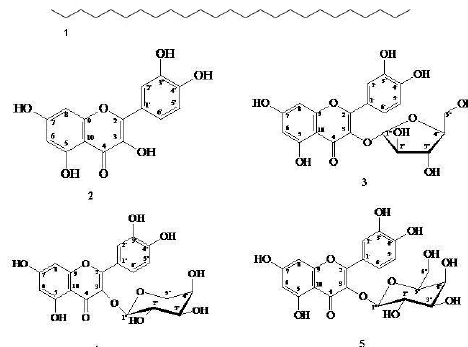
FIGURE 1- Chemical structures of compounds 1-5